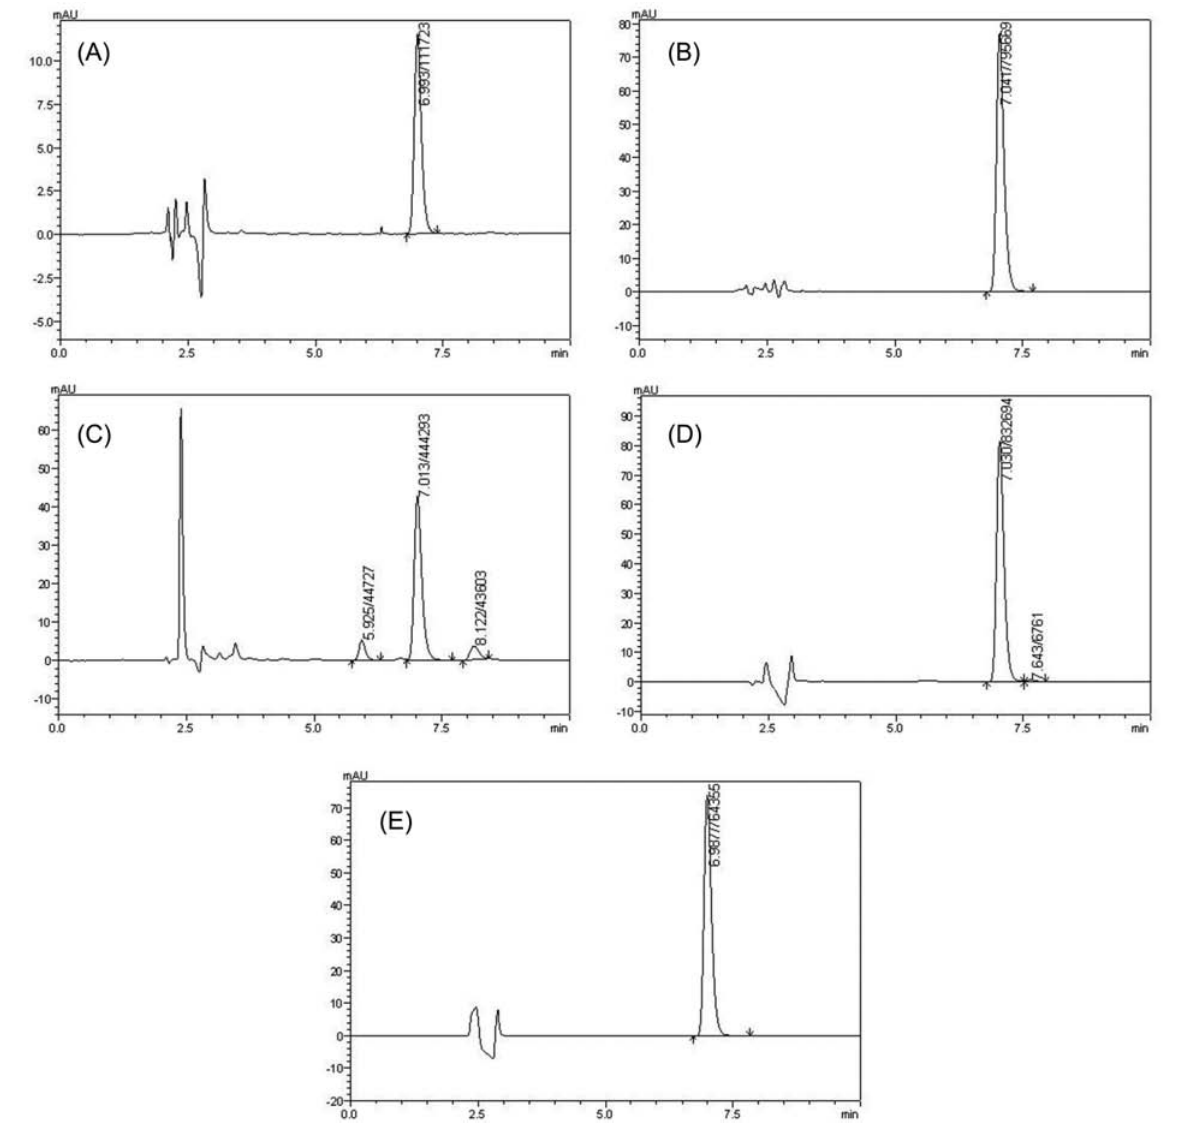
FIGURE 4 - HPLC Chromatograms of RLX solutions submitted to forced degradation for 24 h (A) acidic hydrolysis (HCl 1.0 mol L -1 ), (B) basic hydrolysis (NaOH 1.0 mol L -1 ), (C) oxidative stress (H (E) heat stress (80 °C). Chromatographic conditions: NST column C18 (250 x 4.6 mm x 5µm), mobile phase of water:acetonitrile:tr iethylamine (67:33:0,3 v/v), flow rate 1.0 mL min -1 , injection volume 20.0 µl, UV detection 287 nm and analysis temperature 30